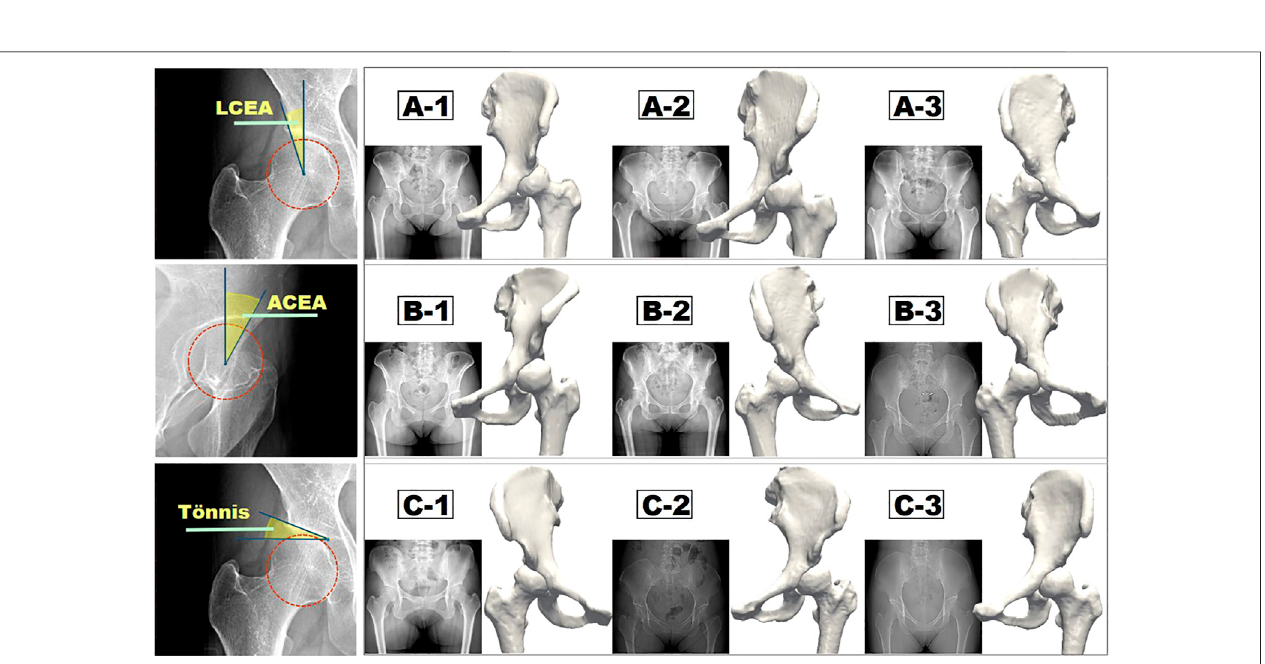
FIGURE 1 | Measurement methods of three major morphological indices (LCEA, ACEA, and Tönnis angle) and the corresponding three groups of reconstructed hip joint